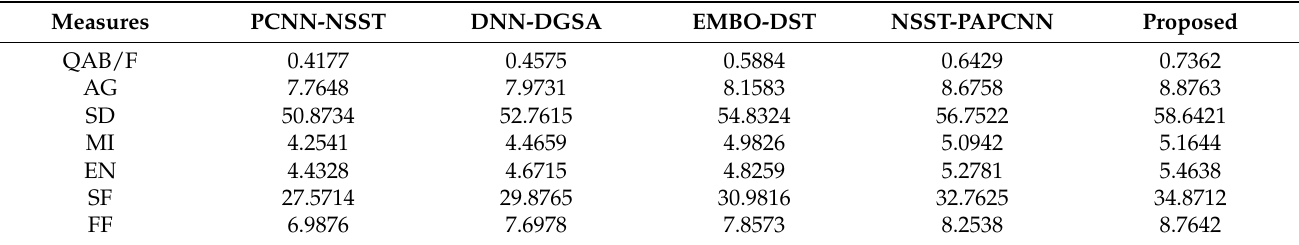
Table 5. Objective computation of various methods on medical image fusion for CT and SPECT images.